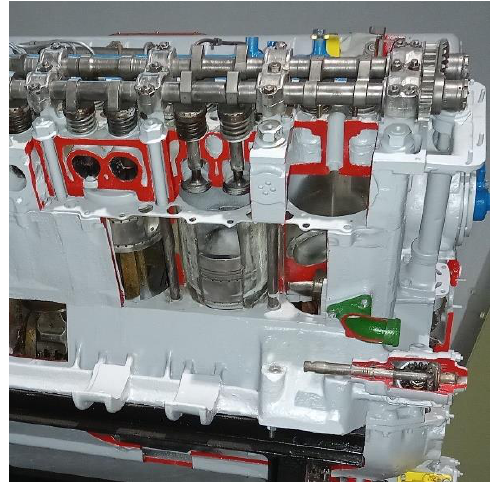
Fig. 13. The W-2 engine, cross-section (Armored Weaponry Museum, Poznan, photo by the